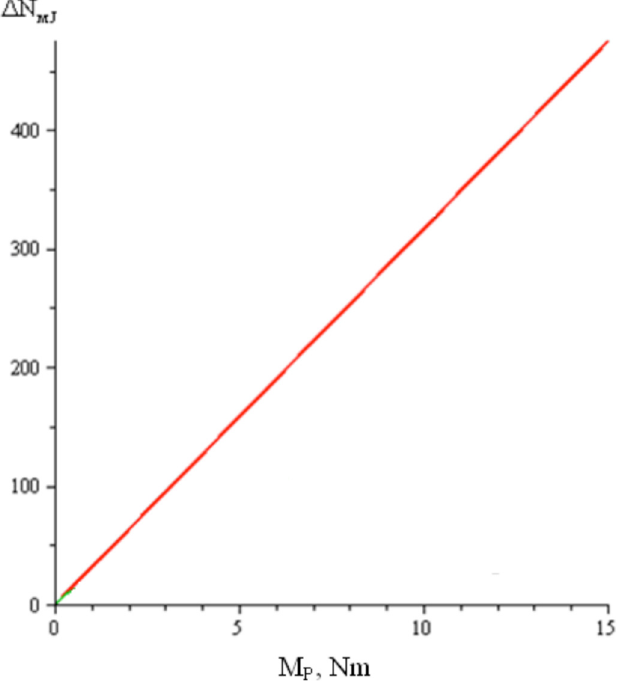
Fig. 2. Static characteristics of the torque MM.